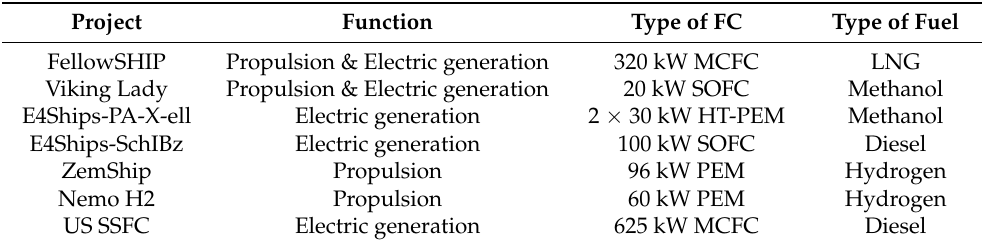
Table 1. Basic information of some fuel cell powered